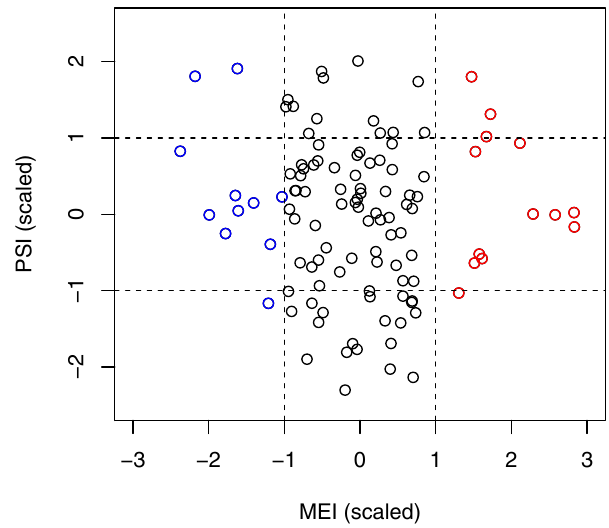
Figure 8. Scatter plot of the new split index (PSI) and MEI, the Mul- tivariate ENSO Index (each normalized to unit variance). Dashed lines add (subtract) 1 standard deviation of MEI and PSI indices, respectively. Red (blue) dots mark warm (cold) ENSO